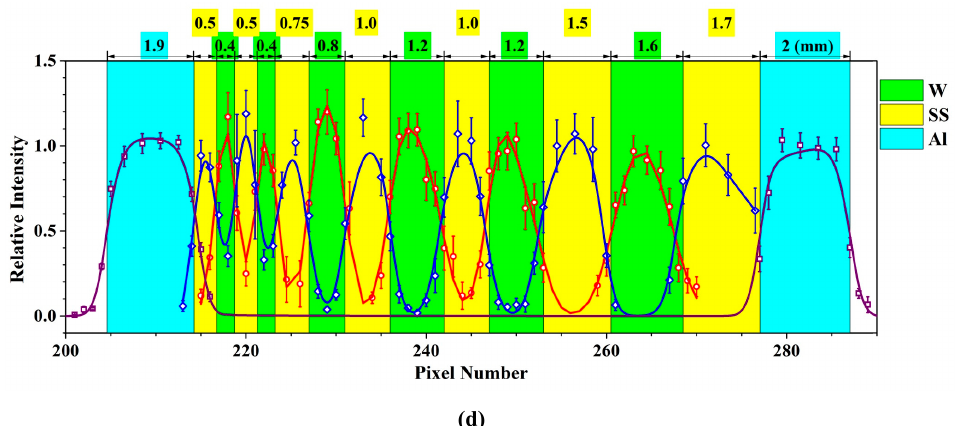
Figure 1. ( a , b ) The conventional and the pinhole neutron diffraction (PIND) setup respectively; ( c ) The schematics of the stainless-tungsten layered sample and diffraction pattern from PIND measurement; ( d ) The analytical results of the stainless-tungsten layered sample for a vertical single channel slit configuration.